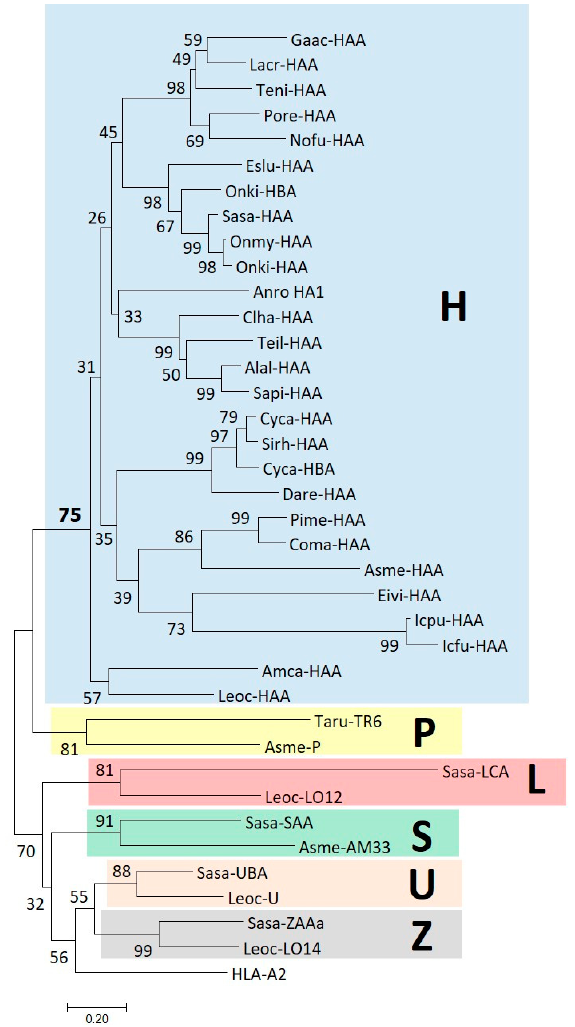
Figure 5. Phylogenetic tree based on α 2 domain amino acid sequences of representative H lineage and other MHC-I molecules as aligned in Figure 4. Clusters with the six different MHC class I lineages found in teleosts are shown with colored boxes. The evolutionary history was inferred using the Neighbor-Joining method [37]. The optimal tree with the sum of branch length = 15.21024459 is shown. The percentage of replicate trees in which the associated taxa clustered together in the bootstrap test (1000 replicates) are shown next to the branches [38]. The tree is drawn to scale, with branch lengths in the same units as those of the evolutionary distances used to infer the phylogenetic tree. The evolutionary distances were computed using the Poisson correction method [39] and are in the units of the number of amino acid substitutions per site. The analysis involved 38 amino acid sequences. All ambiguous positions were removed for each sequence pair. There were a total of 104 positions in the final dataset. Evolutionary analyses were conducted in MEGA7 [41]. Sequence references can be found in legend to Figure 4 and in Supplementary Text